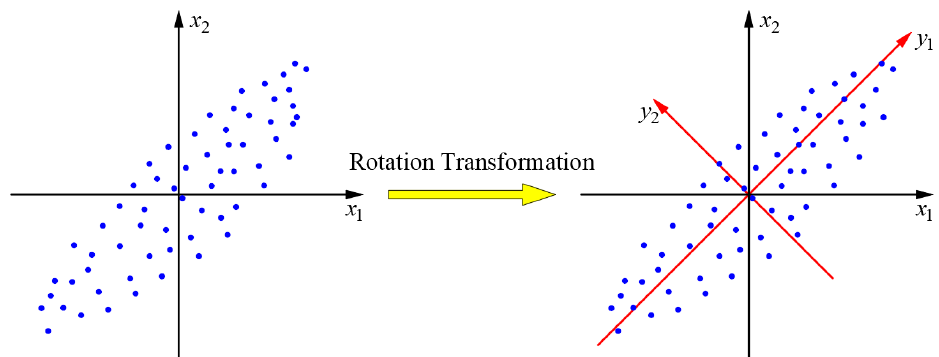
Figure 1. Geometric interpretation of PCA.